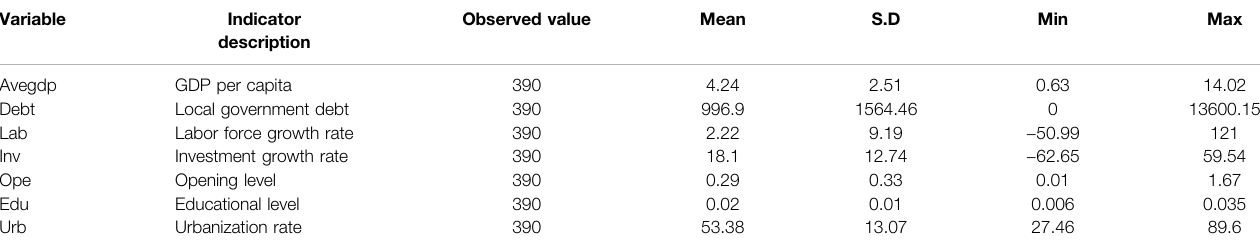
TABLE 1 | Descriptive statistical analysis of table variables (2006 – 2018).